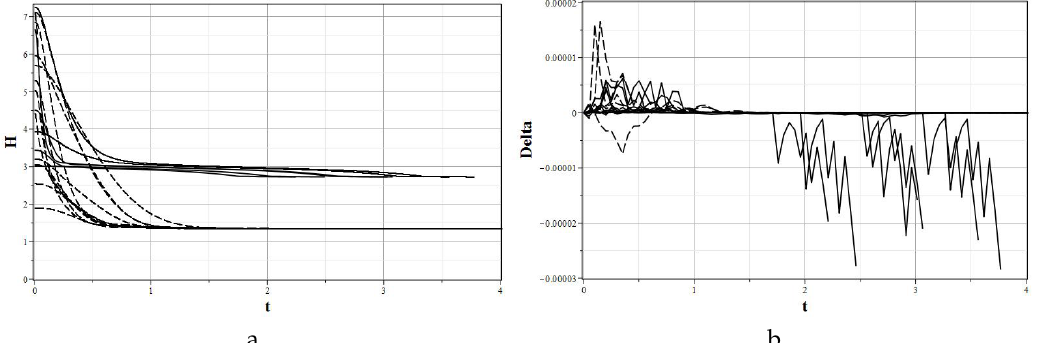
Figure 9. Dependence of H on t ( a ); deviation of the integral of motion ∆ ( t ) from zero ( b